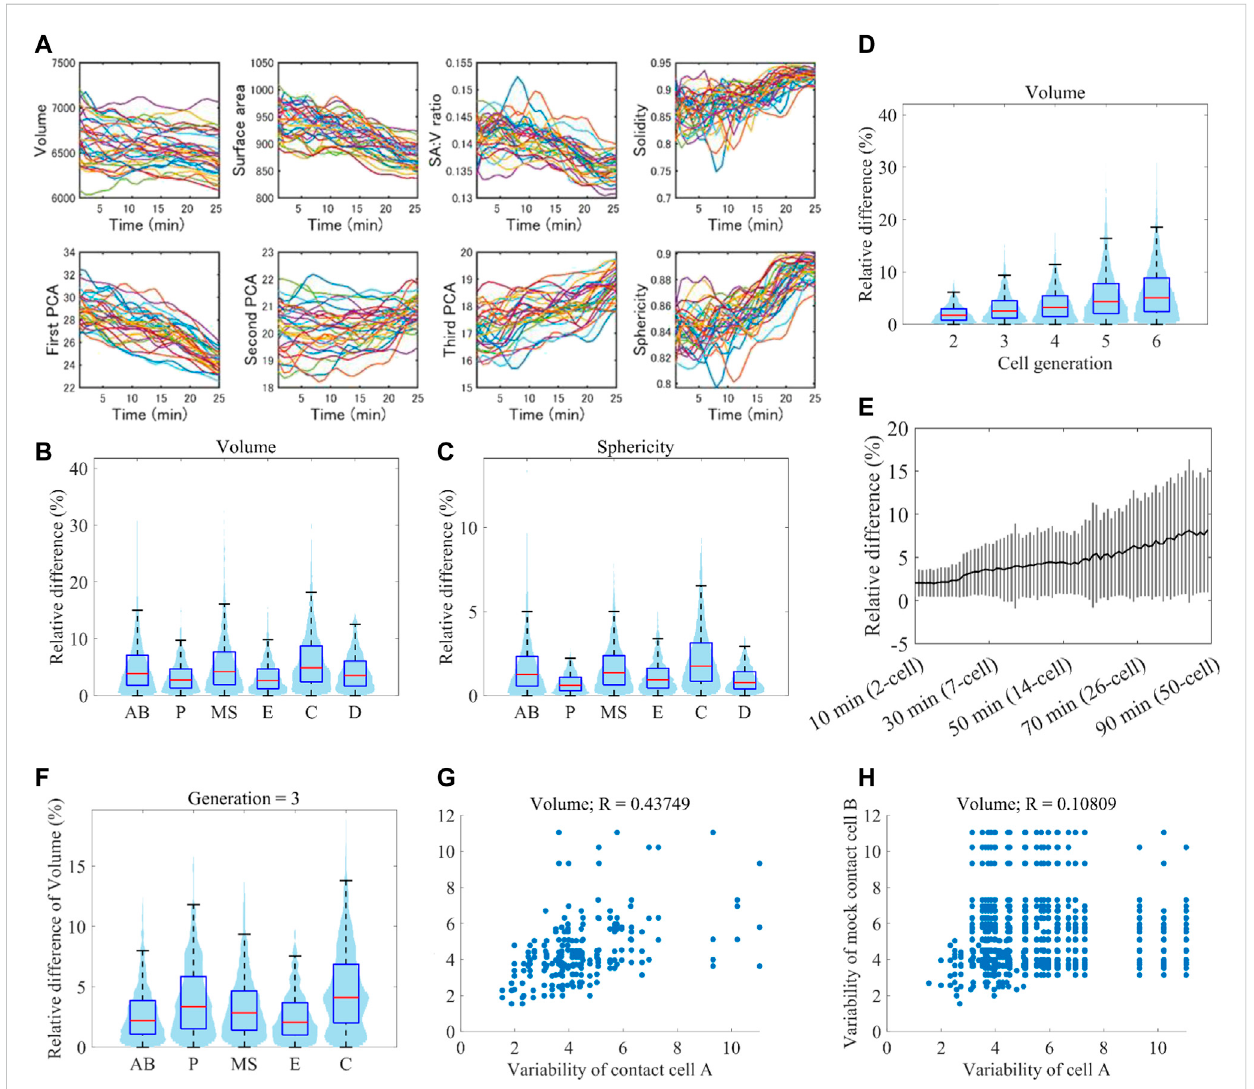
FIGURE 6 Reproducibility of morphodynamics (A) Spatiotemporally normalized single-cell feature dynamics in ABp cell. The dynamics of the 52 embryos are shown in different colors (B and C) Violin and box plots of the variability of volume (B) and sphericity (C) dynamics in each cell lineage. On each box, the central mark indicates the median, and the bottom and top edges indicate the 25th and 75th percentiles, respectively. The whiskers extend 1.5 times the interquartilerange (D) Violin andbox plotsofthevariabilityofvolume dynamics ineach cellgeneration (E) Increaseofvolume variabilitywithtime at single-cell resolution. Black line indicates the average of all cells at the time, and gray vertical lines indicate standard deviations (F) Violin and box plots of the variability of volume dynamics in each cell lineage at the cell generation 3 (G and H) Correlation of variability of volume dynamics between contact cells (G) and mock contact cells at the same cell generation (H)